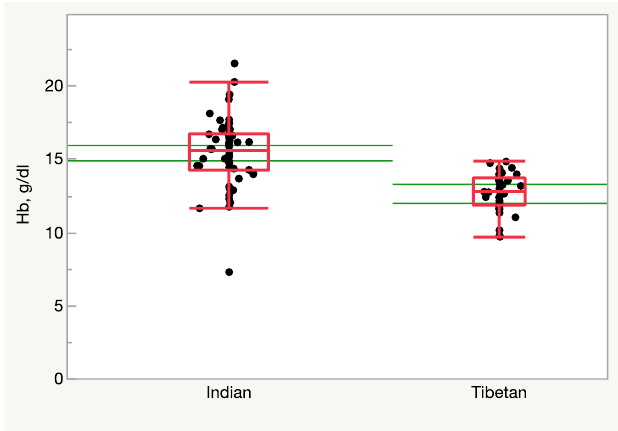
Figure 9. Hemoglobin concentration in the blood of Tibetan and Indian males (n = 37 and 56, respec- tively) residing at <500 m/>20.1 %O 2 . Tibetans display a lower Hb level ( p < 0.0001, S tudent’s t -test). The green lines represent the 95% confidence limits.